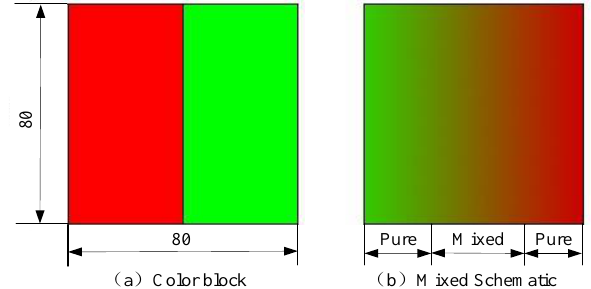
Figure 2. Color block and the schematic of image aliasing.